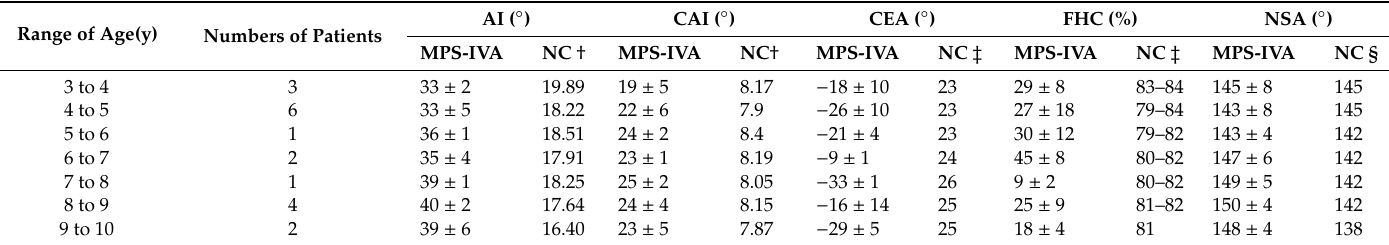
Table 2. Age-matched comparison of parameters in MPS IVA hips with the normal